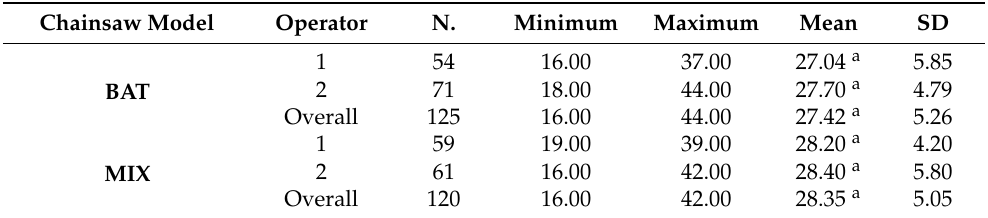
Table 3. Minimum, maximum, mean and SD values for the diameter size of the cut trees. Different superscript letters highlight a significant difference ( p -value < 0.05). Chainsaw Model Operator N.